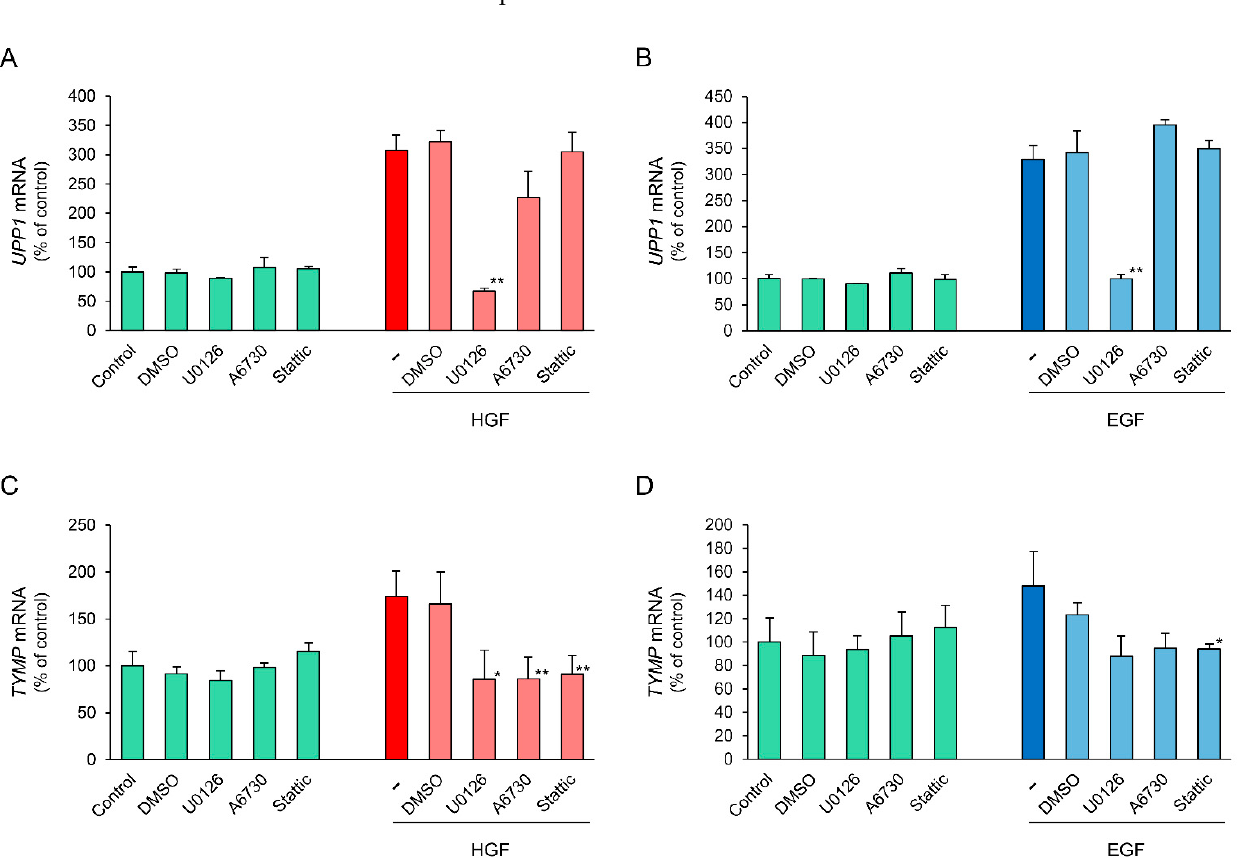
Figure 6. Comparison of inhibitory effects of inhibitors of downstream signaling molecules on HGF- and EGF-induced increase in UPP1 and TYMP mRNA expression. HepG2 cells were pretreated with U0126 (2.5 µ M), a mitogen-activated protein kinase (MEK1/2) inhibitor, A6730 (5 µ M), an anti-apoptotic serine-threonin kinase 1/2 (Akt1/2) inhibitor, and Stattic (10 µ M), a STAT3 inhibitor 15 min before administration of growth factors. The inhibitors were used at the concentration at which they produced no effect on the spontaneous expression of mRNA. The expression level of UPP1 mRNA in cells treated with HGF (50 ng/mL) ( A ) or EGF (50 ng/mL) ( B ) and the expression level of TYMP mRNA in cells treated with HGF ( C ) or EGF ( D ) was measured 6 h after treatment with growth factors, and was expressed as a percentage of that in cells not treated with inhibitors and growth factors. Each bar represents the mean ± SD of 5 experiments. Significantly different from the level in cells treated with growth factor alone: ** p < 0.01, * p <